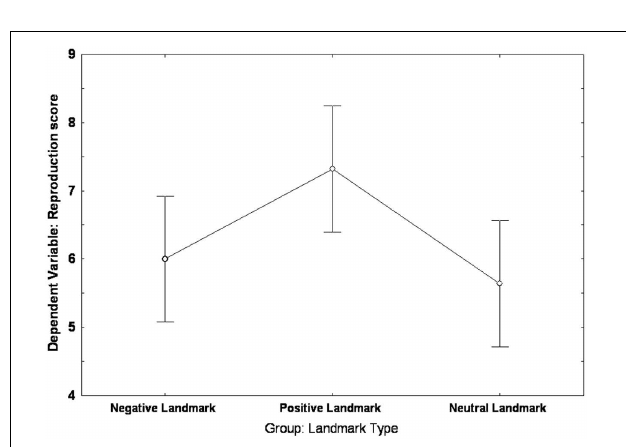
FIGURE 3 | Landmark group differences in the learning score of the Walking Corsi Test. The error bars represent the standard errors of the means (confidence interval = 0.95).